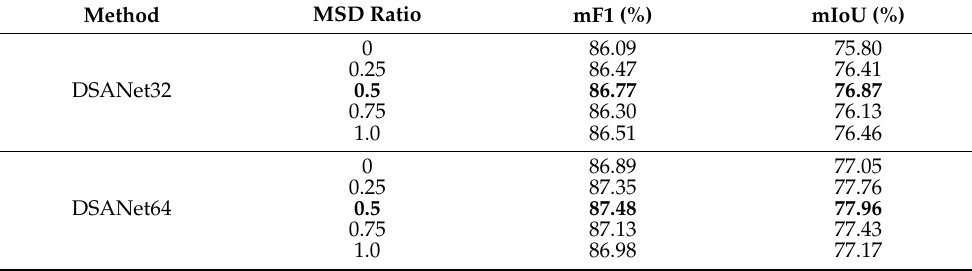
Table 5. Comparison of MSD Losses with Different Ratios on the Potsdam